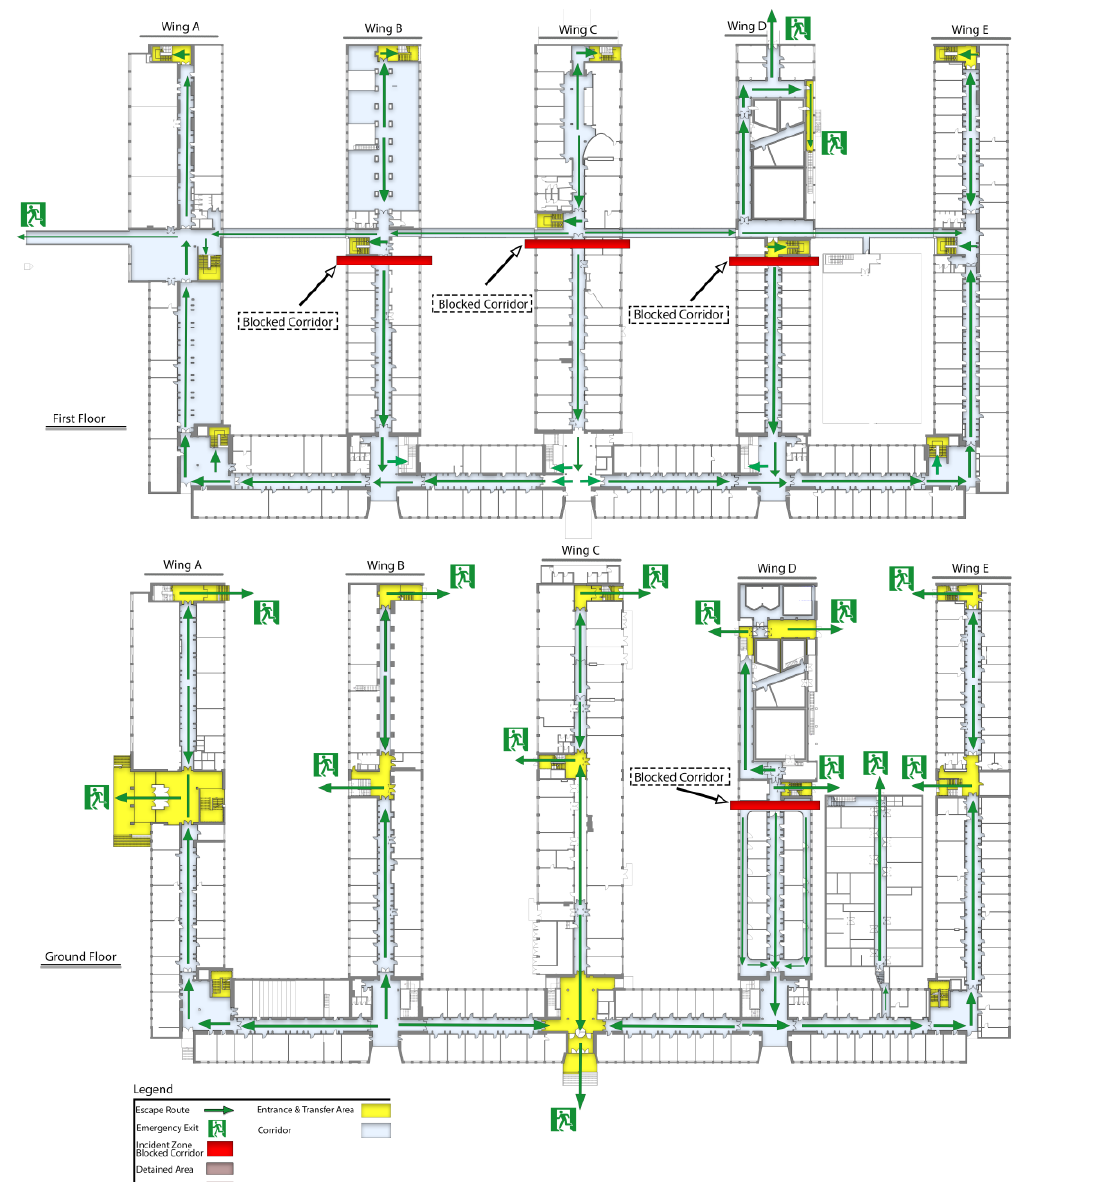
Figure 7. the 2D plan for Scenario B: Flammable gas